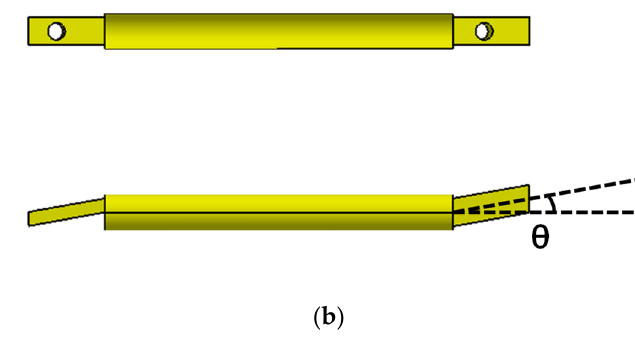
Figure 4. Configuration of truss-link mechanism: ( a ) 3-D truss, ( b ) truss-links with connection angles θ. Table 4. Length and weight of truss-link mechanism.